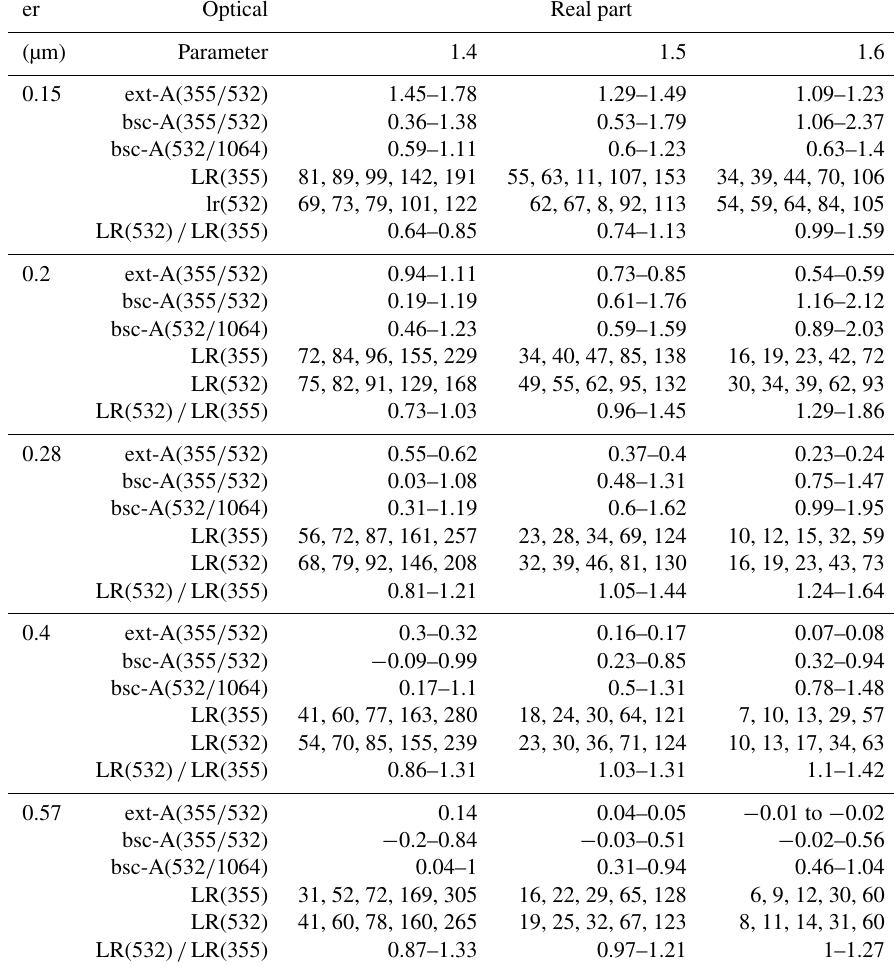
Table 2. Input parameters of the size distributions used in the simulation studies. We used monomodal PSDs with mean radius 100nm and 5 different geometric standard deviations. We used PSDs normalized to one particle per cm 3 . The parameter ext-A(355 / 532) denotes the extinction-related Ångström exponent for the wavelength pair 355 / 532nm, while bsc-A(355 / 532) and bsc-A(532 / 1064) denote the backscatter-related Ångström exponents for the wavelength pairs 355 / 532nm and 532/1064nm respectively. LR(355) and LR(532) denote the lidar ratios at 355 and 532nm respectively. LR(532) / LR(355) denotes the colour ratio of the lidar ratios at 355 to 532nm. We use five different imaginary parts for each pair of effective radius and real part. For that reason we obtain five different lidar ratios for each of these pairs. In the case of the Ångström exponents, we show the range from minimum to maximum value instead of the five individual values. That range of values arise from the choice of different input parameters used for the particle size